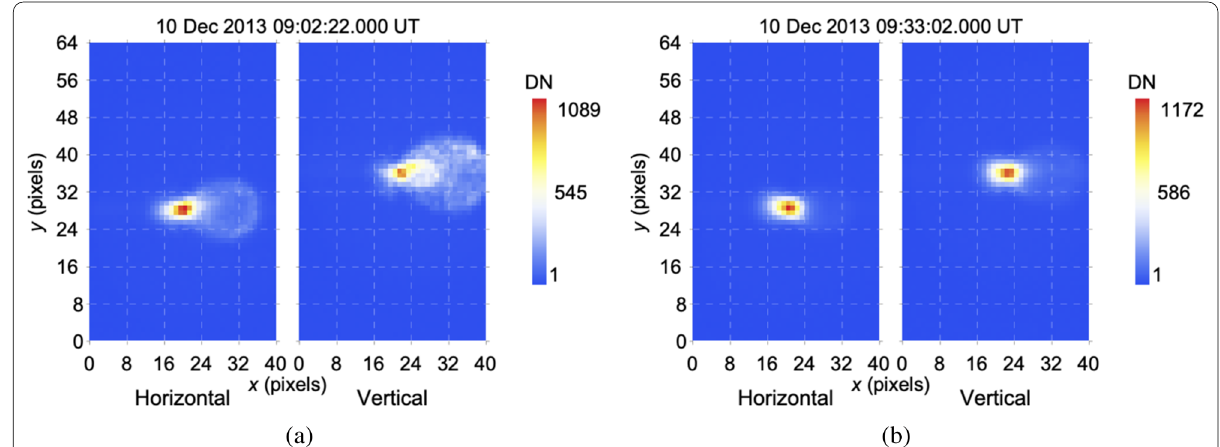
Fig. 1 Swarm C TII images from the first operation. ( a ) First images with both sensor high voltages at operational levels. ( b ) Best focused images from the first orbit. Data number or “DN” refers to analog-to-digital converter output. See Knudsen et al. (2017) for details regarding the formation and interpretation of